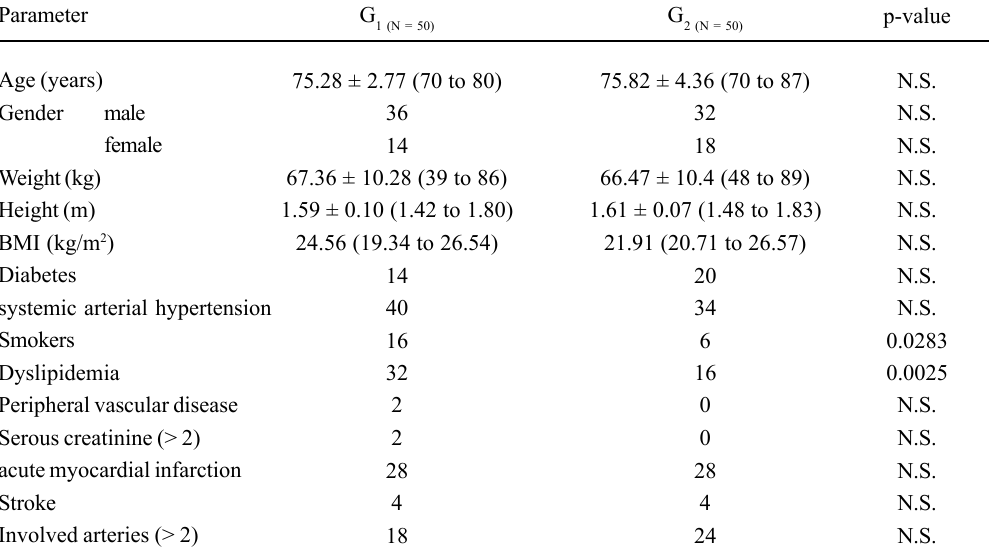
1. Profile of patients submitted to myocardial revascularization with and without